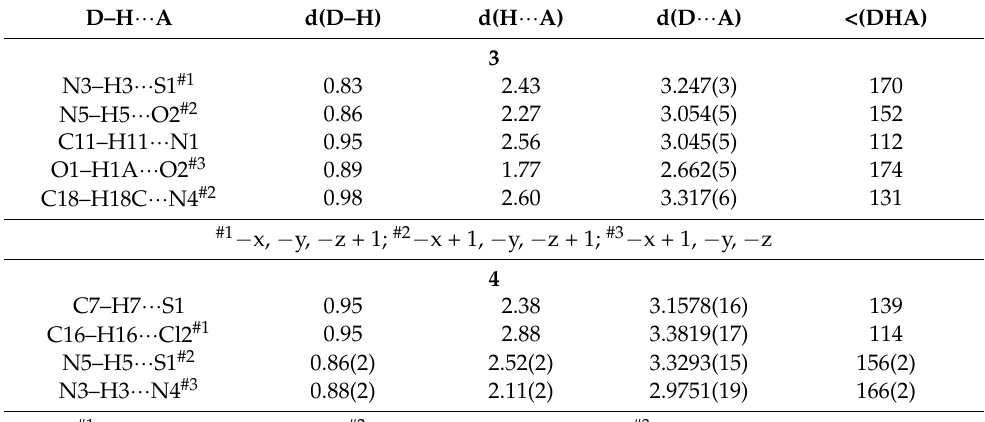
Table 3. Hydrogen bonds for 3 and 4 [Å and ◦ ].